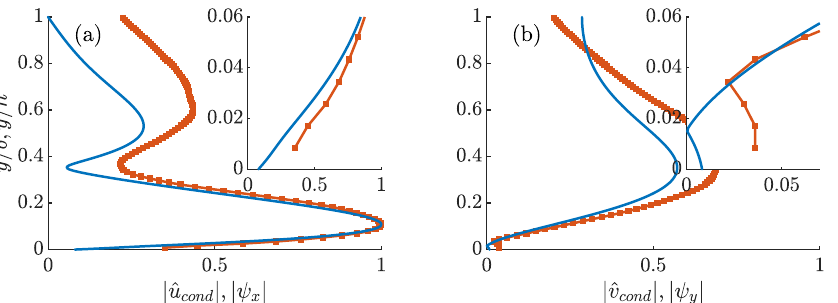
Figure 11. Comparison of the amplitude between the conditional averaged experimental results (red solid lines with square markers), and the resolvent mode with eddy viscosity (blue solid lines) for the compliant wall. Figure ( a ) is the streamwise modes, and figure ( b ) is the wall-normal modes. Markers for the experimental results indicate locations where measurements were taken. Mode amplitudes are normalized by their peak streamwise amplitude. Insets are the near wall close-up views for y / h , y / δ ≤ 0.06. Parameters for resolvent with eddy viscosity are Re τ = 410, ( k x , k z , c + ) = ( 2.78,0,15.15 ) .